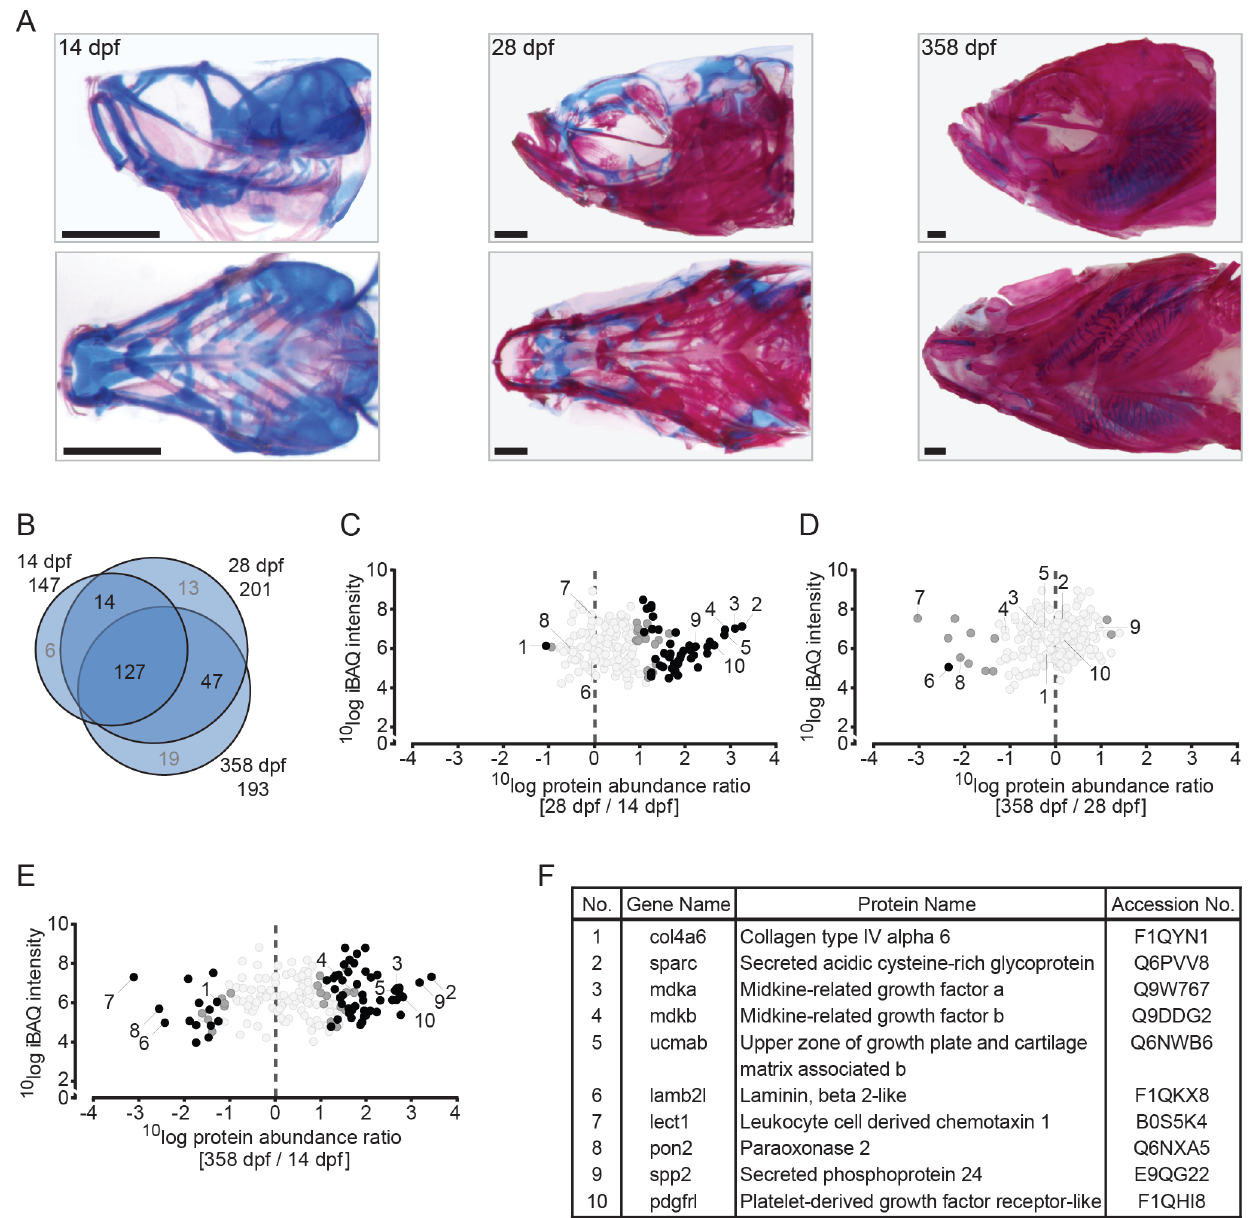
Figure 2. Quantitative analysis of the zebrafish craniofacial skeleton by MS-based proteomics. (A) Alcian blue/alizarin red stain of cartilage/bone structures in the craniofacial skeleton. Lateral (top) and ventral (bottom) images of all three time point used for protein extraction (left to right: 14 dpf, 28 dpf, 358 dpf). (B) VENN diagram of proteins selected for label-free quantification, with areas drawn to represent the number of proteins. Total number of proteins as well as distinct and common proteins are indicated for each time point. Proteins that did not qualify for label- free quantification are depicted in grey. (C-E) Ratio abundance plots showing log total iBAQ intensities versus log protein abundance ratio of the 28/14 dpf (C), the 358/28 dpf (D) and the 358/14 dpf (E) craniofacial skeleton ratios of all the proteins that met the strict criteria for label-free quantification (black circles, significantly differential abundant proteins at FDR= 0.01; dark grey circles, significantly differential abundant proteins at FDR= 0.05; light grey circles, no significant change in abundance). The numbers correspond to the proteins listed in 2F. (F) Table containing several of the significant differentially abundant proteins within the cranial skeleton. Specific proteins are discussed in the text.